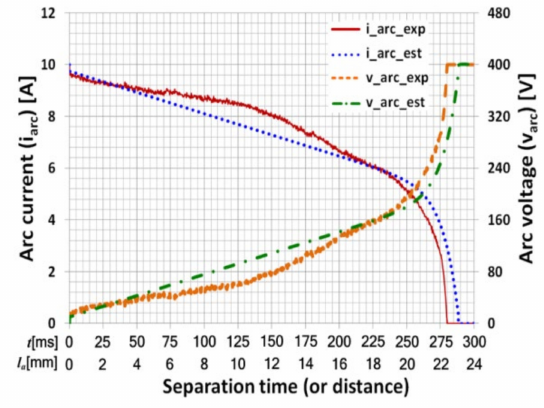
Figure 11. Series arc current/voltage waveform: separation speed 80 mm/s, power supply voltage 400 V, load power 4